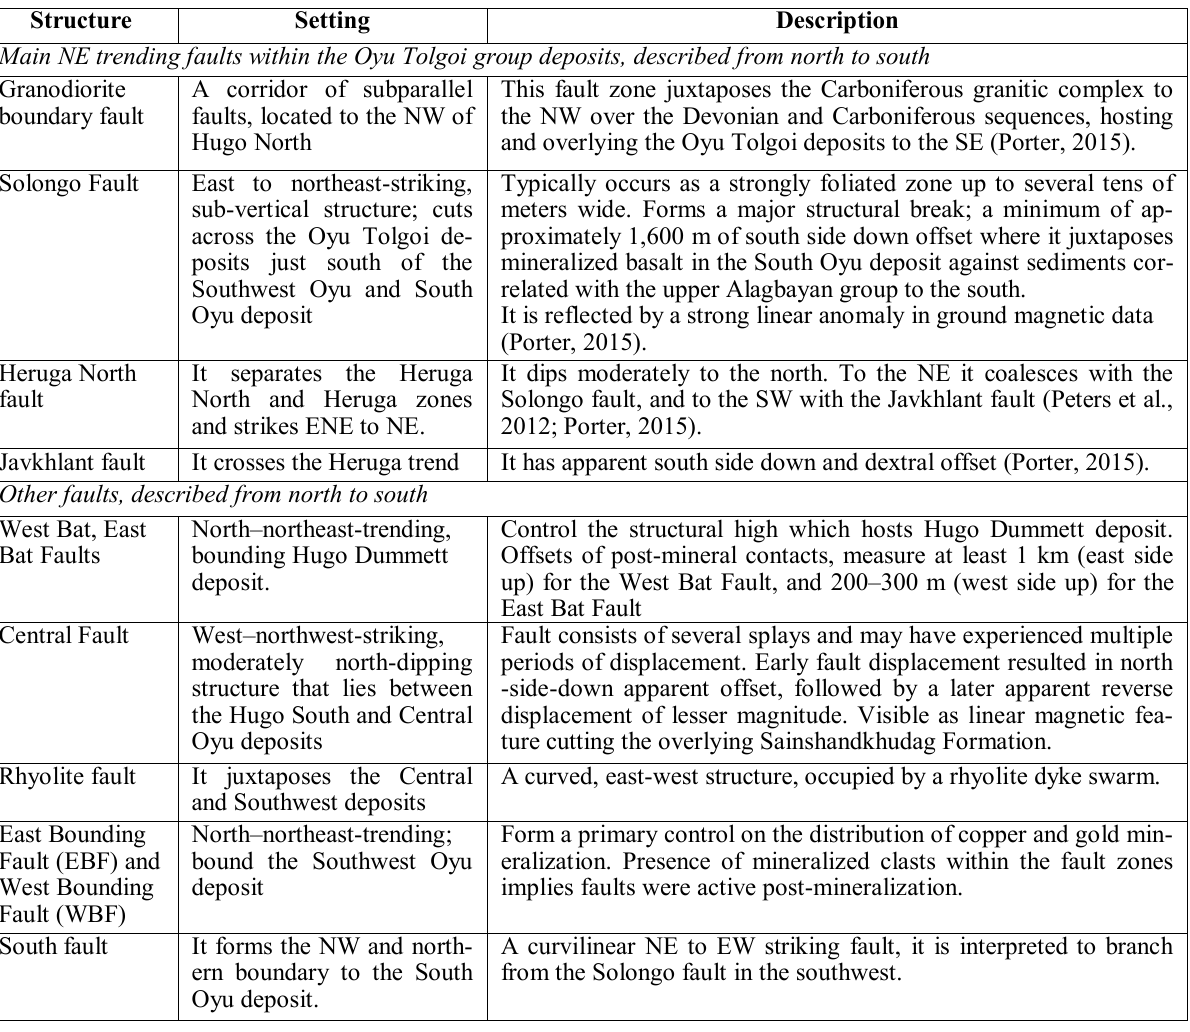
Table 1. Faults in the Oyu Tolgoi group deposits area (Figs. 2 and